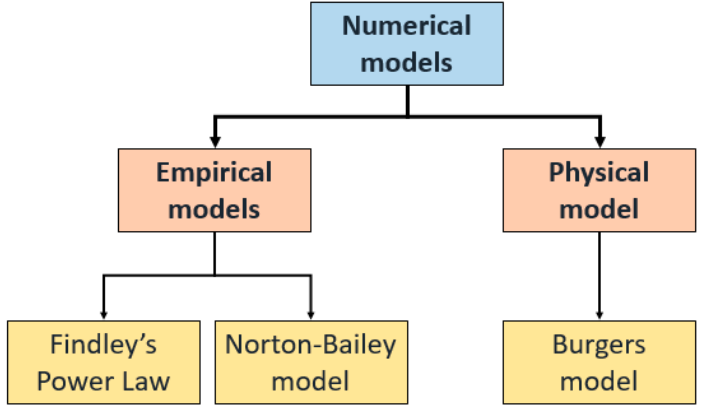
Figure 10. Classification of numerical models for creep analysis.